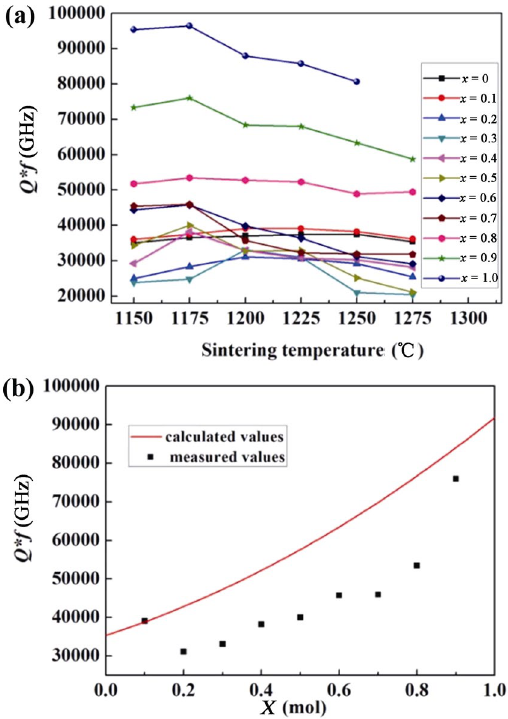
Fig. 8 (a) Q × ƒ values of (1– x )CoTiNb 2 O 8 – x ZnNb 2 O 6 ceramics as a function of sintering temperatures, and (b) the variety of Q × ƒ values of (1– x )CoTiNb 2 O 8 – x ZnNb 2 O 6 ceramics with x values.